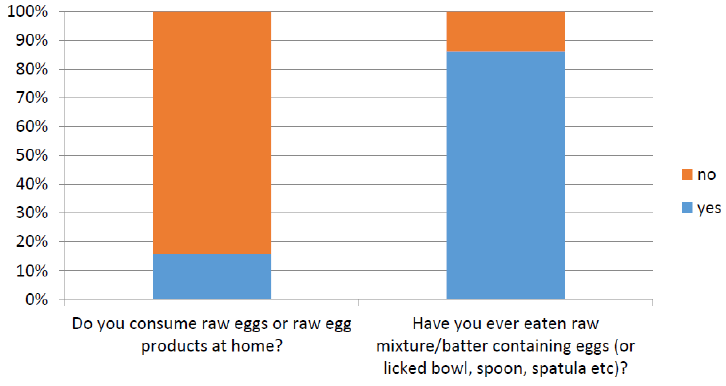
Figure 1 . The percentages of participant responses for the questions “Do you consume raw eggs or raw egg products at home?” and “Have you ever eaten raw mixture/batter containing eggs (or licked bowl, spoon, spatula, etc.)?”